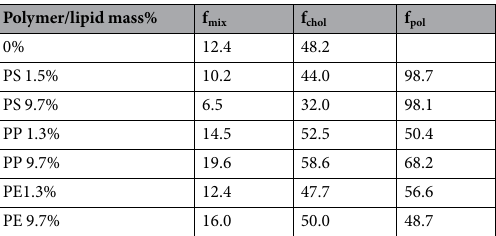
Table 3. Influence of the polymers chains on phase separation in ternary systems DPPC/DLiPC/Chol. f mix , f chol and f pol indicate the fraction of DPPC-DLiPC contacts, Chol-DLiPC contacts, and polymer-DLiPC contacts respectively. In the case of ideal mixing, the expected values for f mix , f chol and f pol are 0.27, 0.73, and 0.73 (the lipid mixture has a DPPC:DLiPC ratio of 27:73). Statistical uncertainties are below 5%, except for f pol in the case of PE (10%